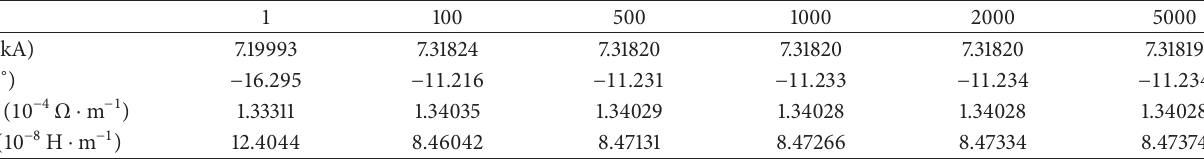
Table 1: Dependence of current in inner conductor and impedance replacing 1m of pair of conductors in Example 1 on 𝑛 , for 𝑓 = 50 Hz. 𝑛 1 100 −16.295